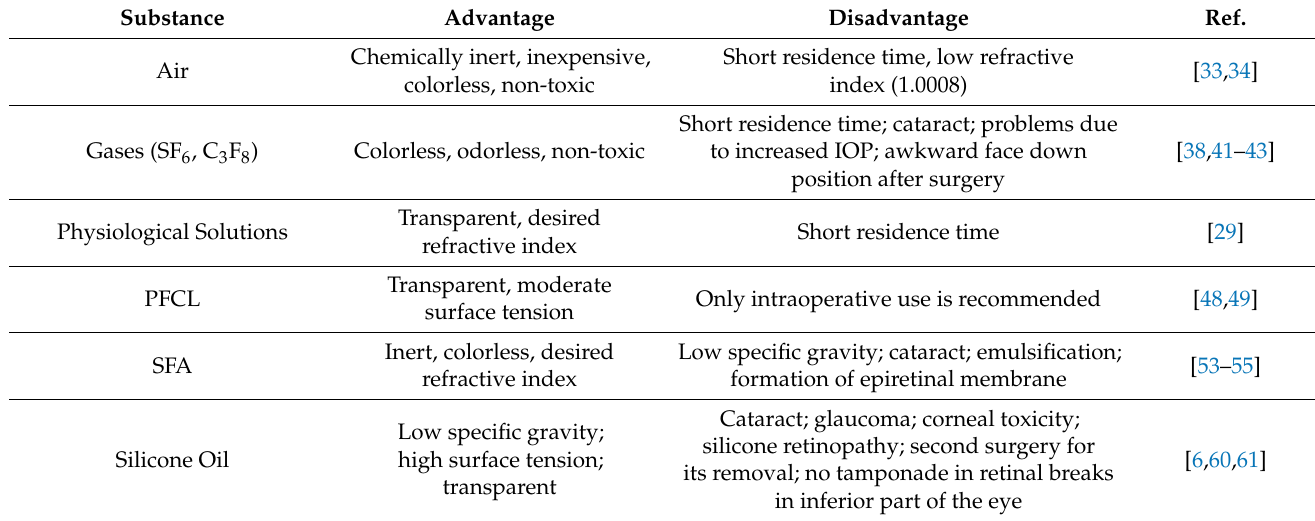
Table 2. Overview of the vitreous substitutes used